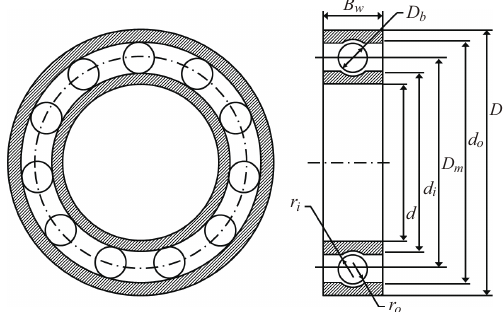
Figure 9. Configuration of a rolling element bearing.